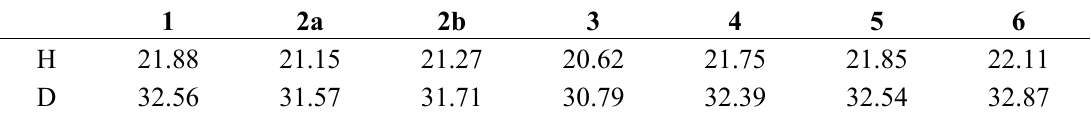
Table 1. The optimized α value in GTF as the nuclear basis function in each system.